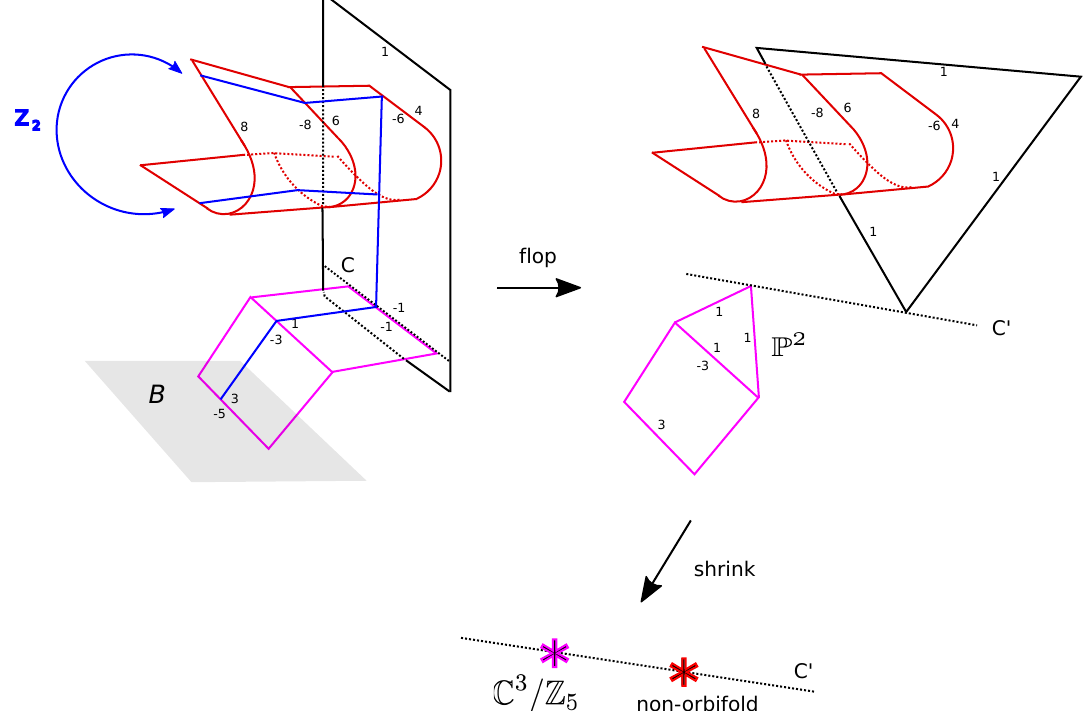
Figure 6 . Geometry of the (cid:0) 5 theory. In blue we have drawn the E 6 (cid:12)ber over the generic point of the ruling, the F 6 surface however meets the F 1 corresponding to the center of the a(cid:14)ne E 6 Dynkin diagram along a double section, which gives rise to the monodromy corresponding to the Z 2 outer automorphism projecting E 6 to F 4 . In the 5D limit, the curve C 0 decompacti(cid:12)es. As it is similar to other examples already presented, we have omitted the other 5D SCFT limit described by pure F 4 gauge